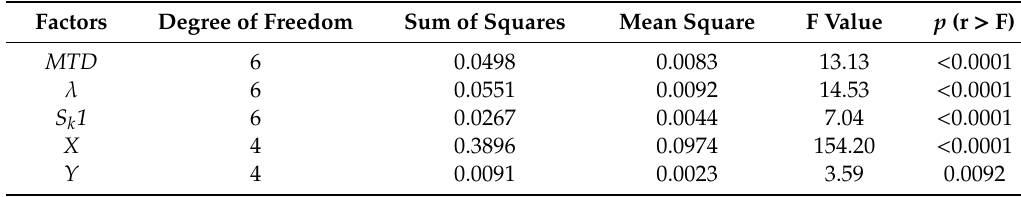
Table 8. Factor test results of final DF 60